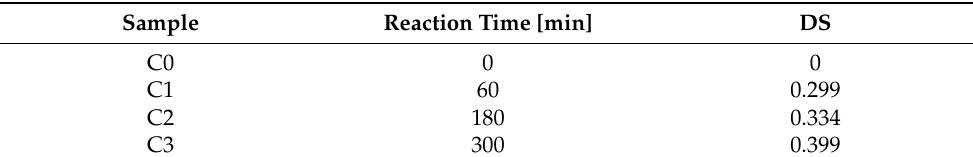
Table 1. Labelling of the CNC samples according to reaction time and their corresponding calcu- lated DS.